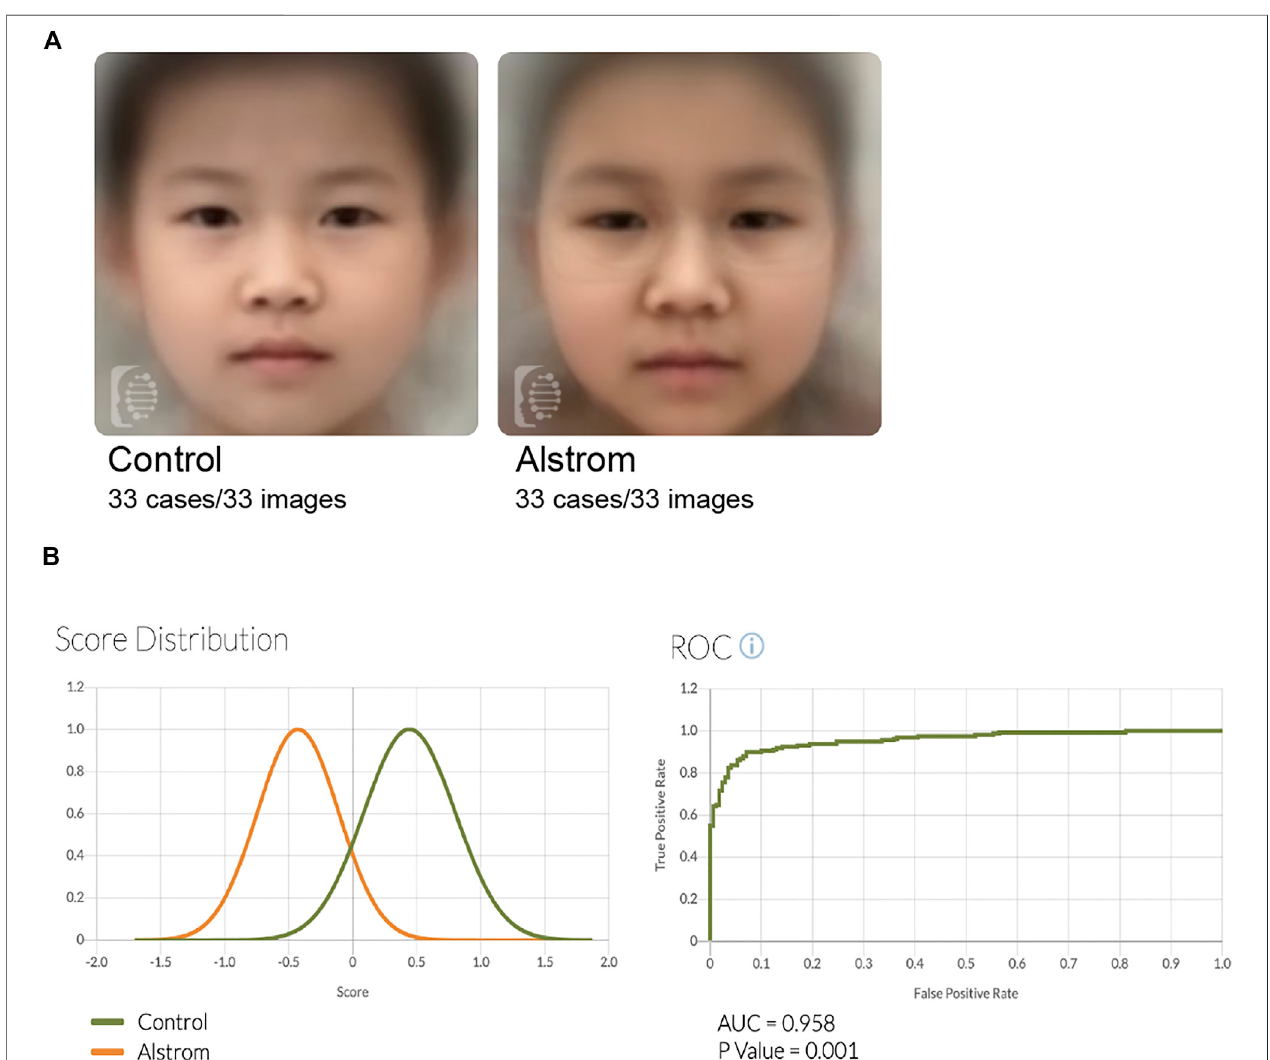
FIGURE 3 | Facial analysis of patients and controls. (A) Composite photos computed from age-matched images of ALMS patients and controls. (B) Score distribution and ROC curves of the comparison results of ALMS patients and controls.